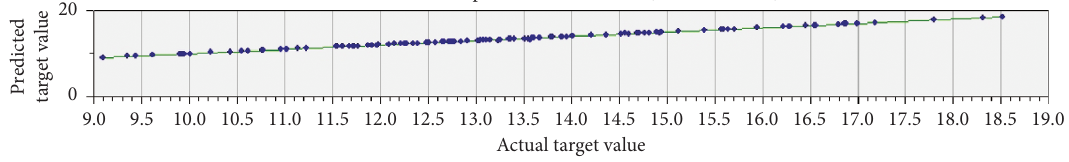
Figure 5: Dependence of the actual and predicted values of the target variable.